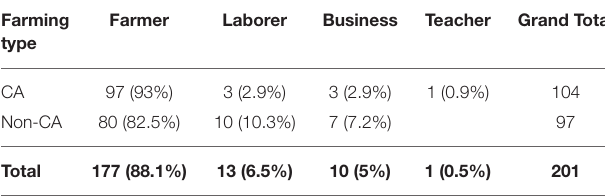
TABLE 7 | Respondent’s main occupation (Household survey, n = 201). Farming type